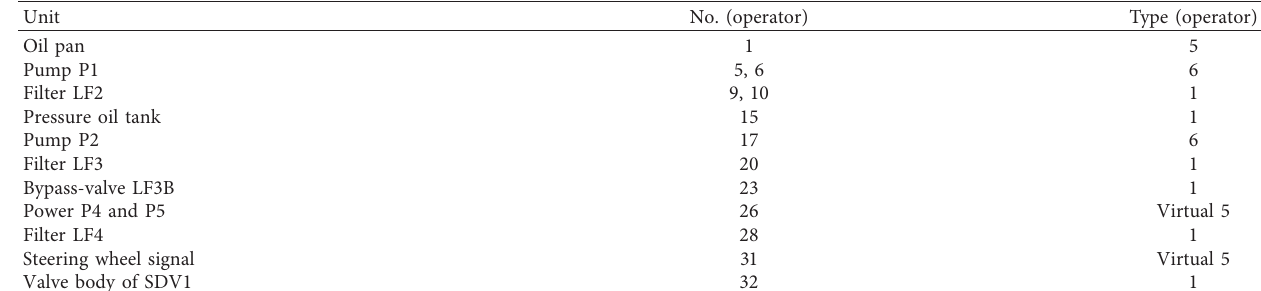
Table 10: Function GO operator in the GO model of